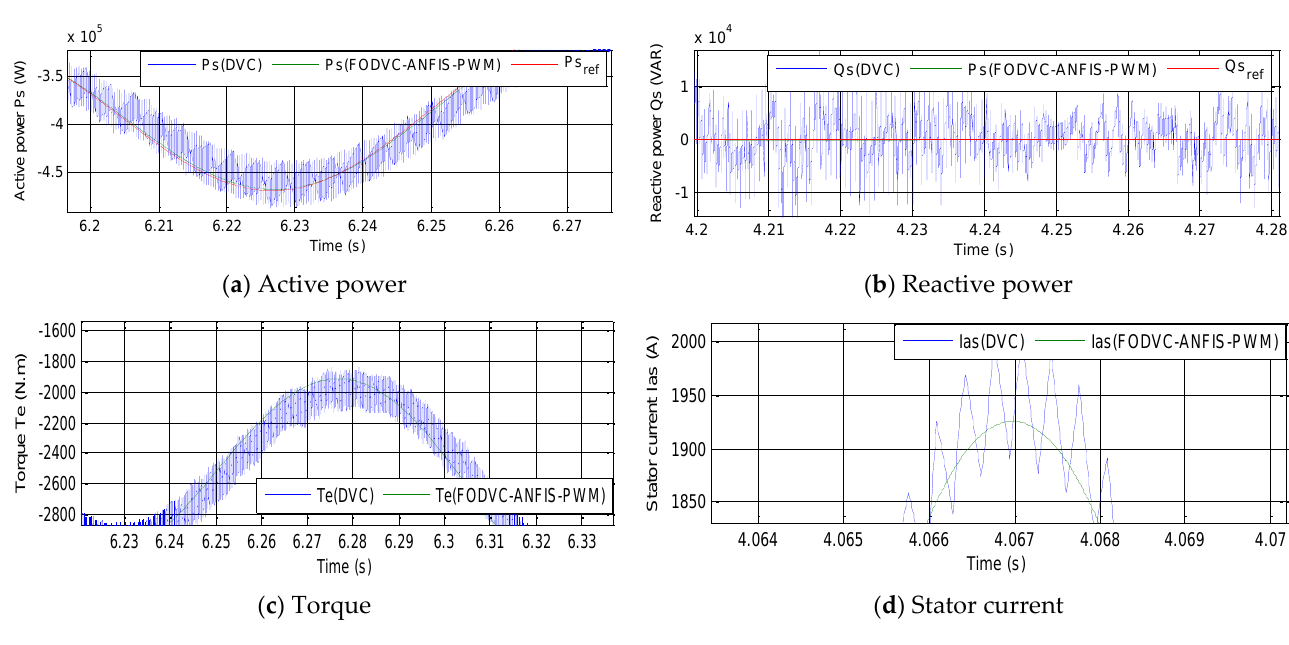
Figure 17. Simulated results from the second test.